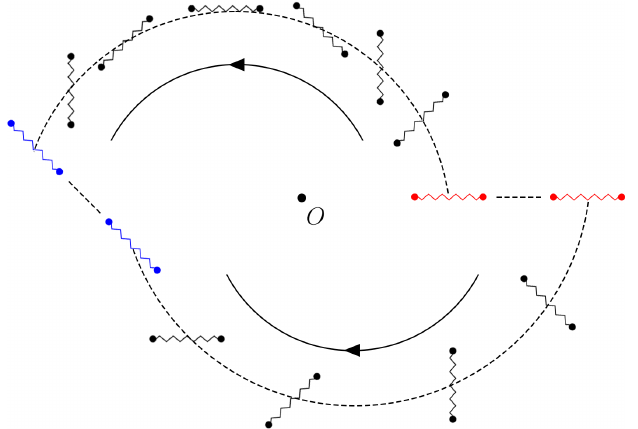
Figure 9 . The transformations of branch cuts of the t 2 -plane following the path from O B to O A on the U -plane for SU(2) π